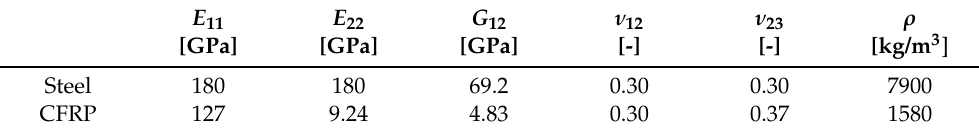
Table 1. Material properties of the CFRP layer and steel